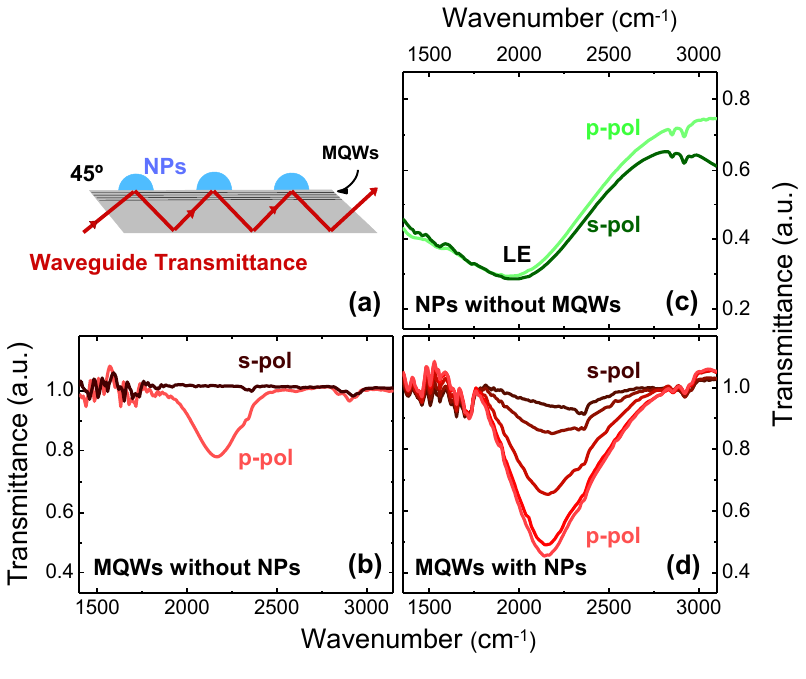
Figure7: (a)Configurationforthewaveguide transmittance measurements. (b) to (d): Waveguide transmittance of the MQW sample prior to growth of the NPs (b), the reference sample with NPs and without MQWs (c), and the same MQW sample from (b) after growth of the NPs (d). By rotating the external polarizer by 90 ° the polarization of the incident light respect to the MQWs is changed from purely s - polarized, to purely p -polarized. Each step in the color gradient in (d) corresponds to a 22.5 ° rotation of the polarizer. Units in (b) and (d) can be